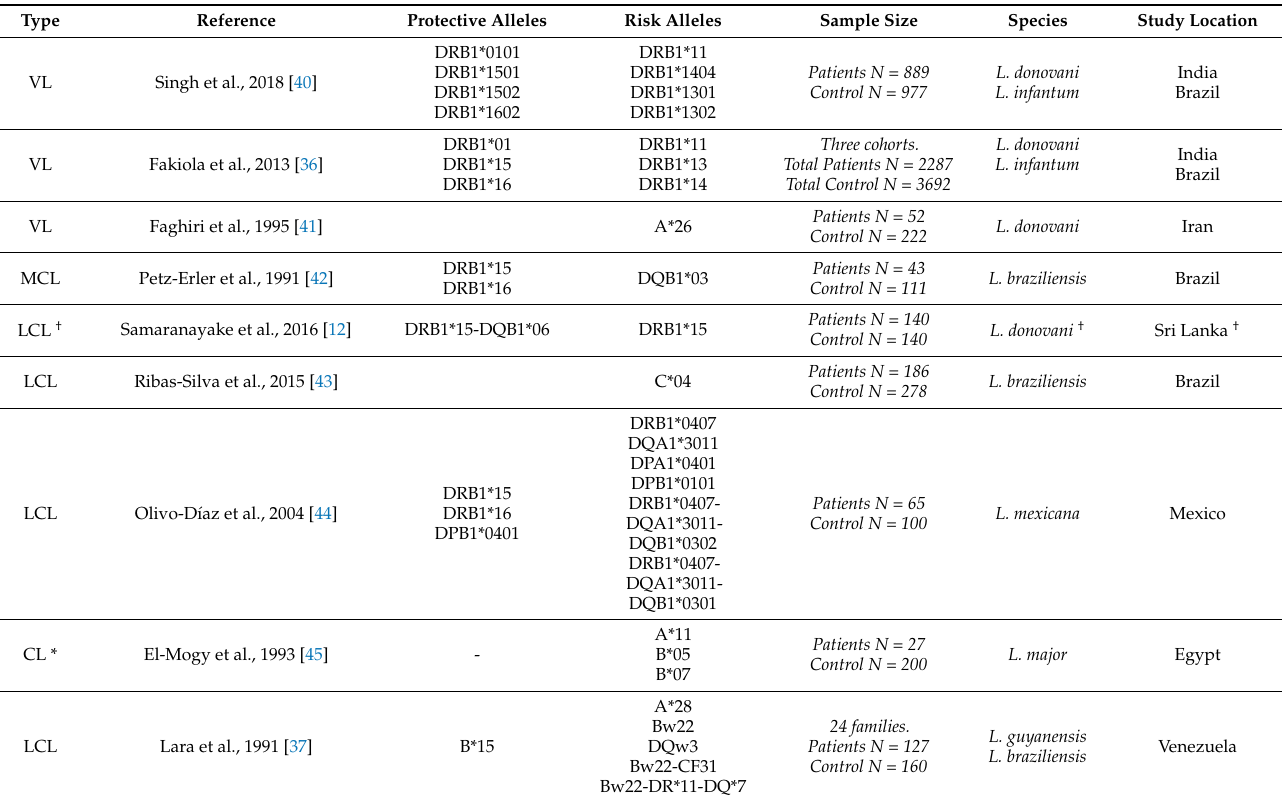
Table 1. Leishmaniasis-associated HLA alleles extracted from the literature were divided into those that confer protection against contracting the disease (Protection) and those that increase the susceptibility for the disease (Risk). CL: Cutaneous leishmaniasis; LCL: Localized cutaneous leishmaniasis; DCL: Diffuse cutaneous leishmaniasis; MCL: Mucocutaneous leishmaniasis; VL: Visceral leishmaniasis. † = L. donovani does not typically cause CL, but this species has been reported to cause both VL and CL in the Sri Lankan population [39]. * = Included patients with both LCL and